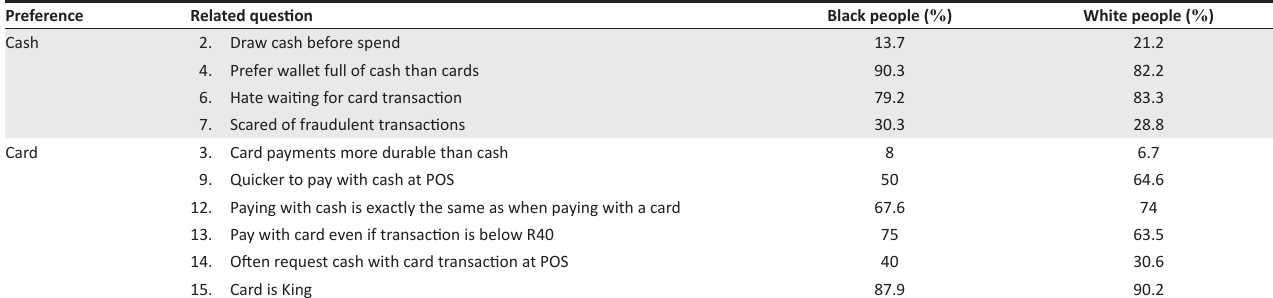
TABLE 1: The preference of either cash or card according to race. Preference